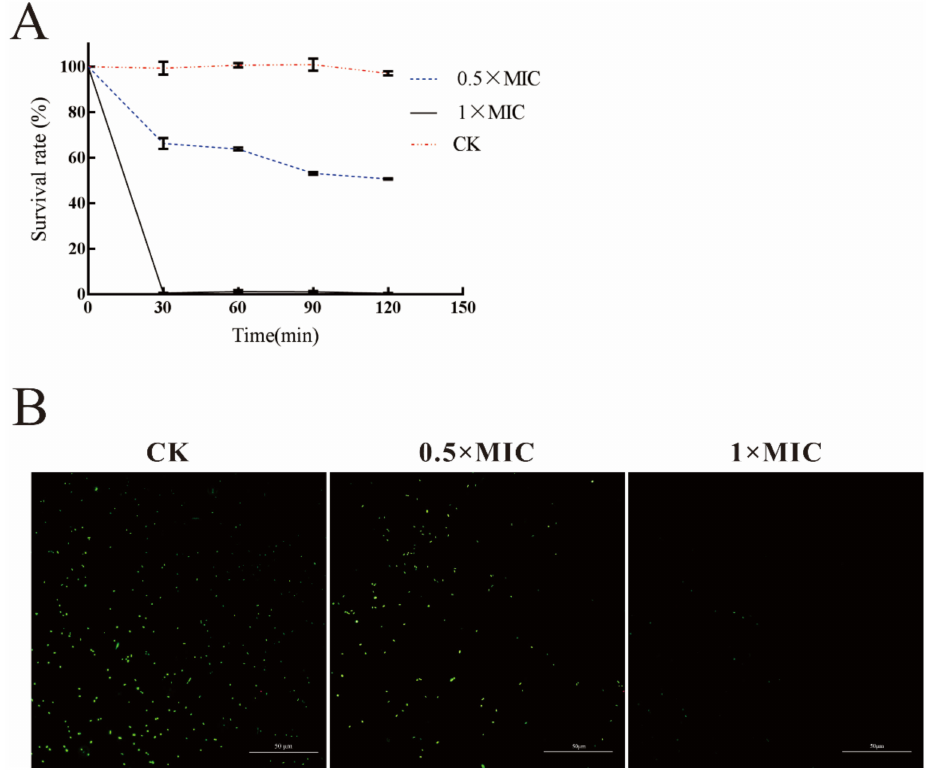
Figure 3. Antimicrobial activity of LN against A. hydrophila. ( A ) Bactericidal activity of LN at different treated concentrations. ( B ) Microscopic observation of A. hydrophila stained by SYTO ® 9 at different treated concentrations of